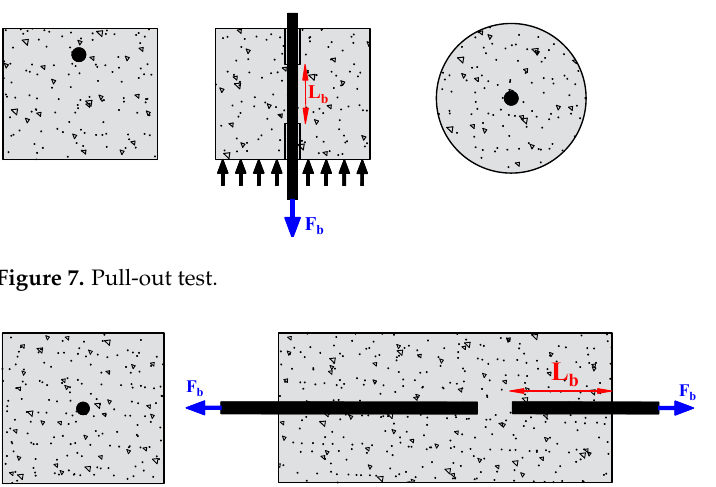
Figure 8. Pull-out test modified by Auyeung.